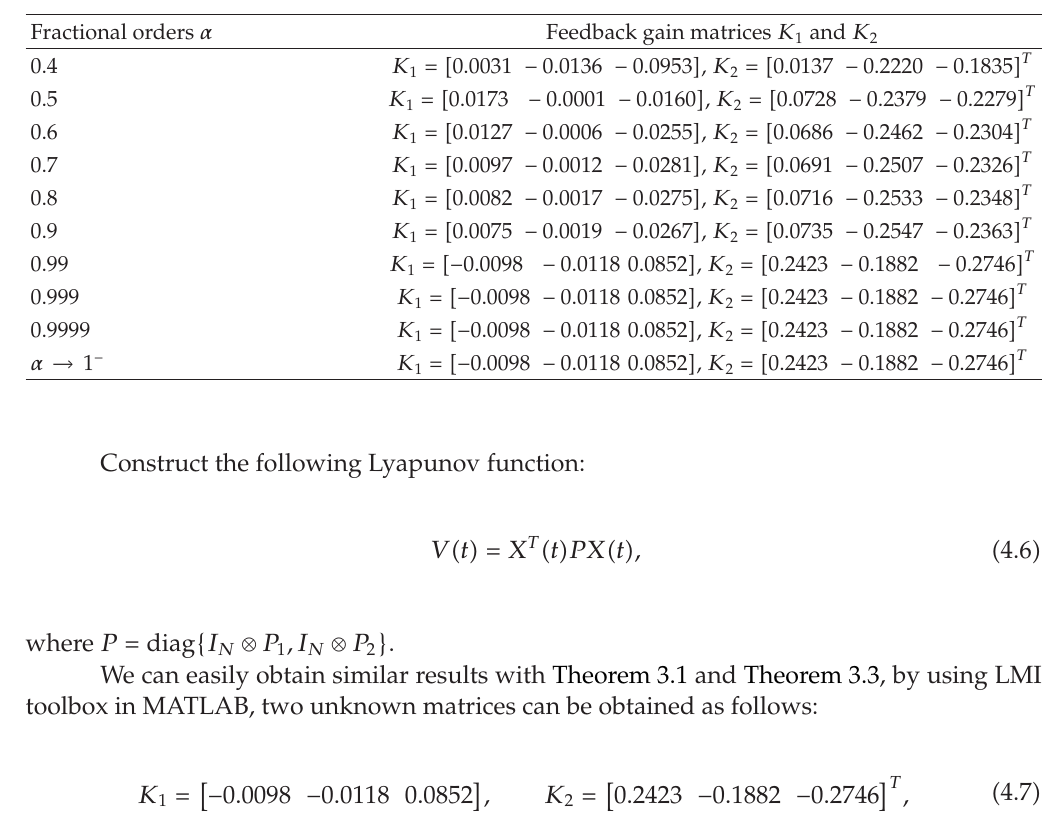
Table 1: Controller gain matrices K 1 and K 2 for di ff erent fractional order α